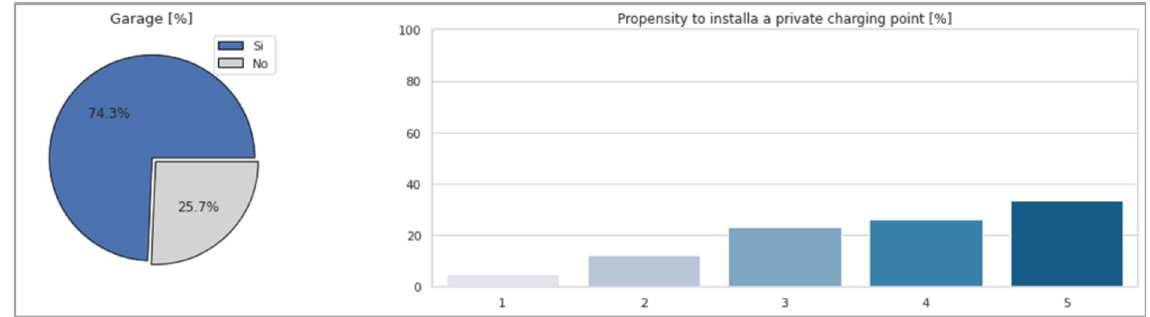
Fig 10. The percentage of users owning a Garage and their propensity to Install a private charging point .